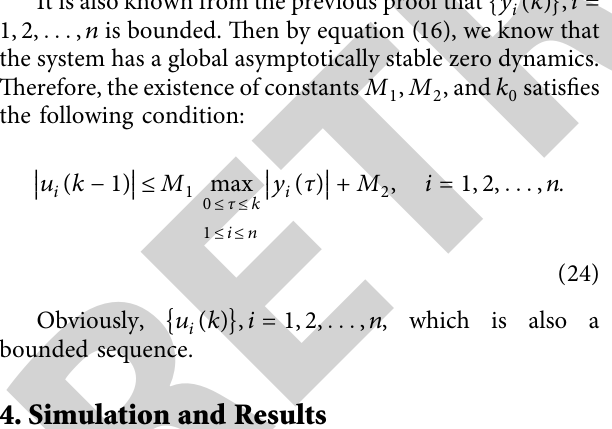
Figure 1: Structure of the control